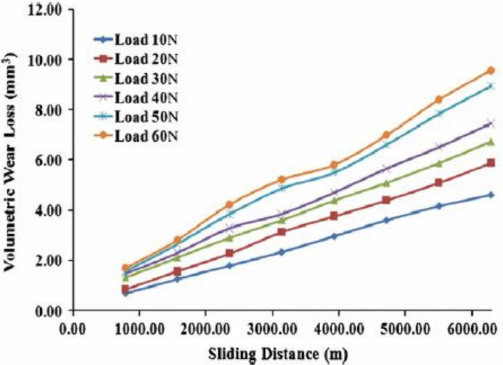
Figure 16. Load application effect on the wear (volumetric loss) with the increment in the sliding distance on Al6061–6 wt% silicon carbide-reinforced composites [136].